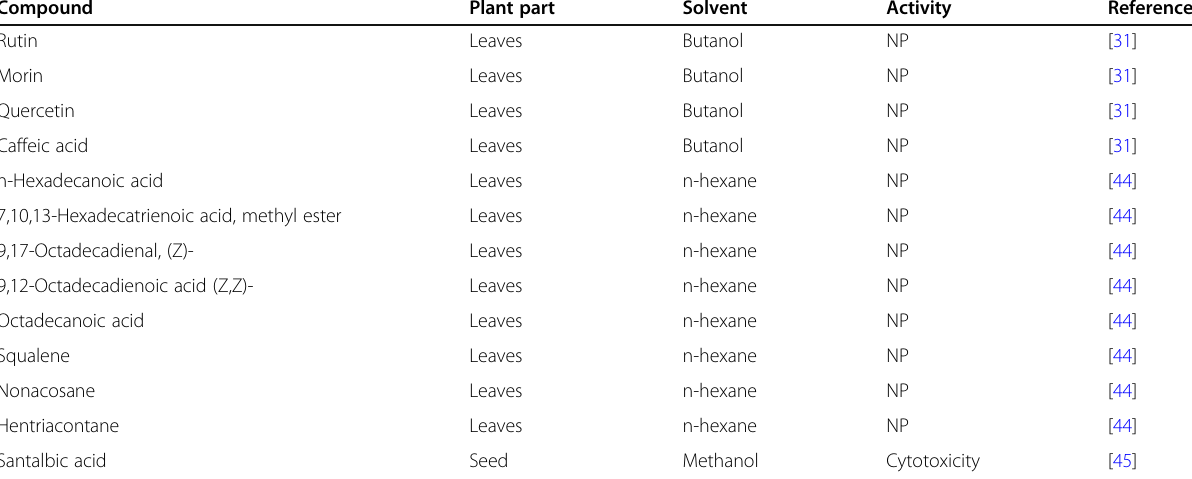
Table 3 Chemical compounds isolated and identified from Olax subscorpioidea and their reported pharmacological activities